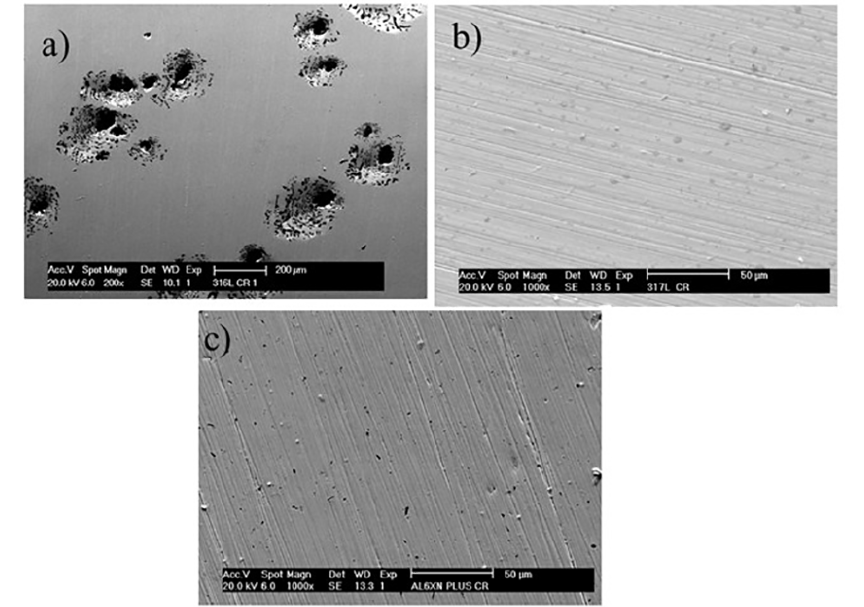
Figure 9. SEM image of the alloys surface in the as-received condition after the cyclic polarization tests in CO -saturated aqueous medium. a) 316L, b) 317L, and c) AL-6XN PLUS TM 2